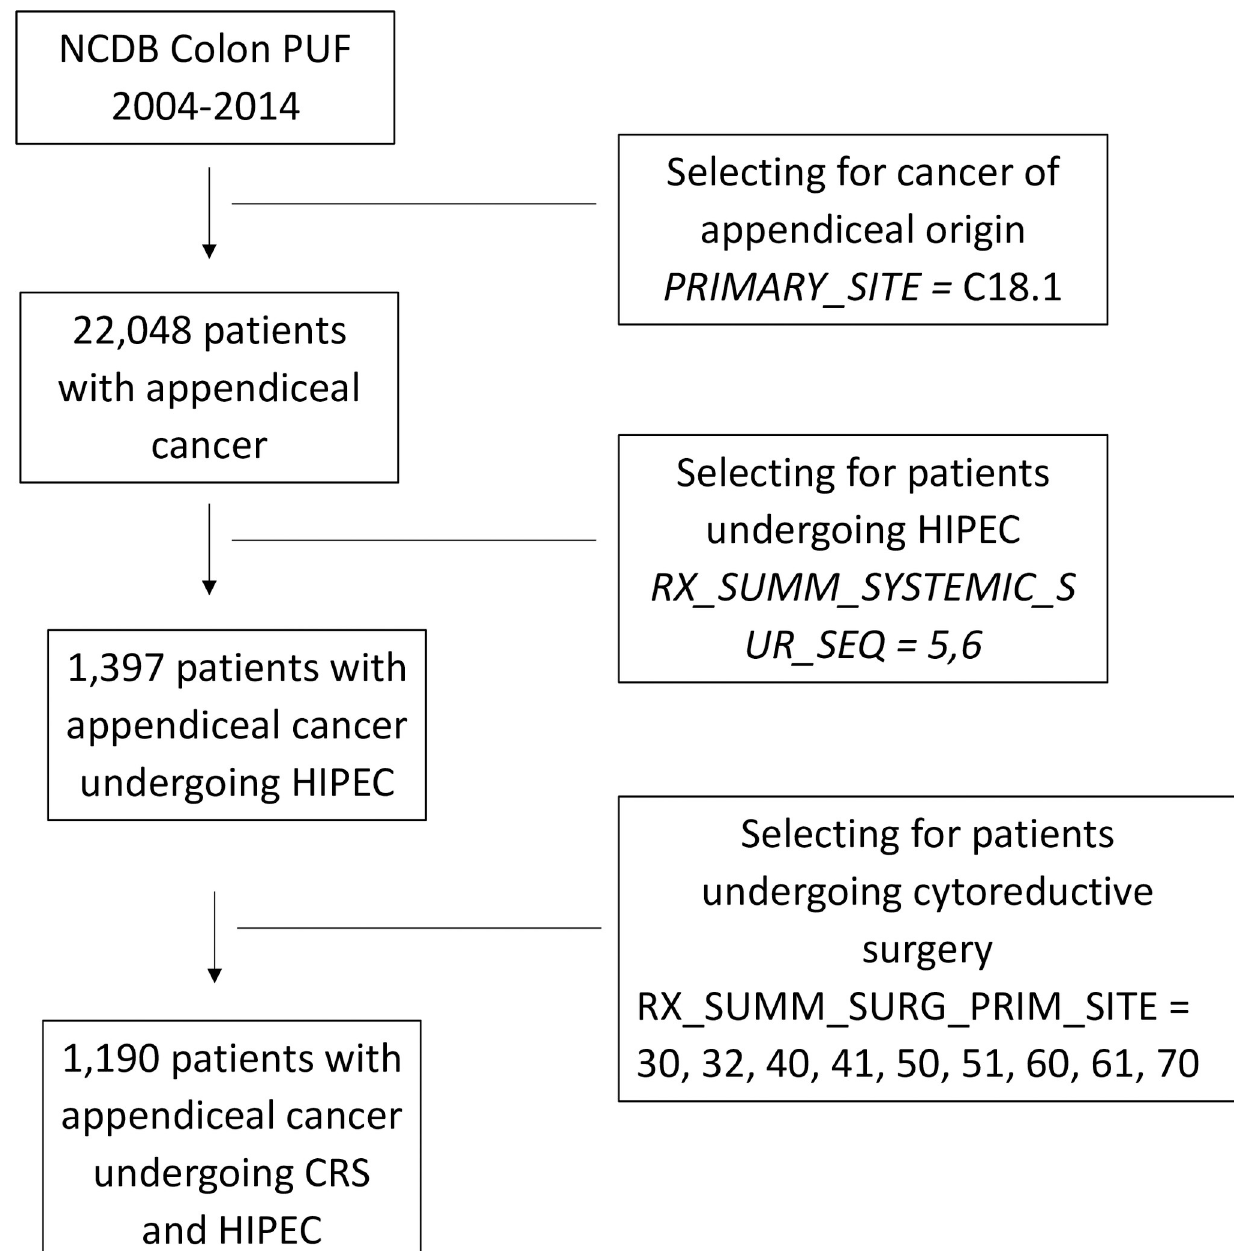
Fig 1. Selection of patients with appendiceal cancer undergoing HIPEC and